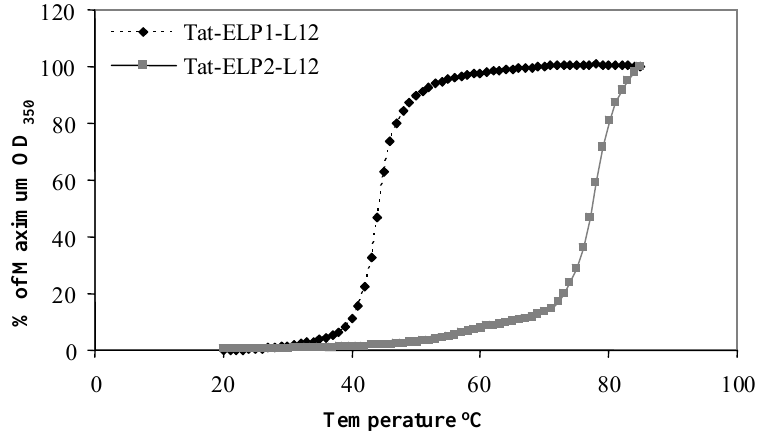
Figure 1. Thermal properties of Tat-ELP-L12